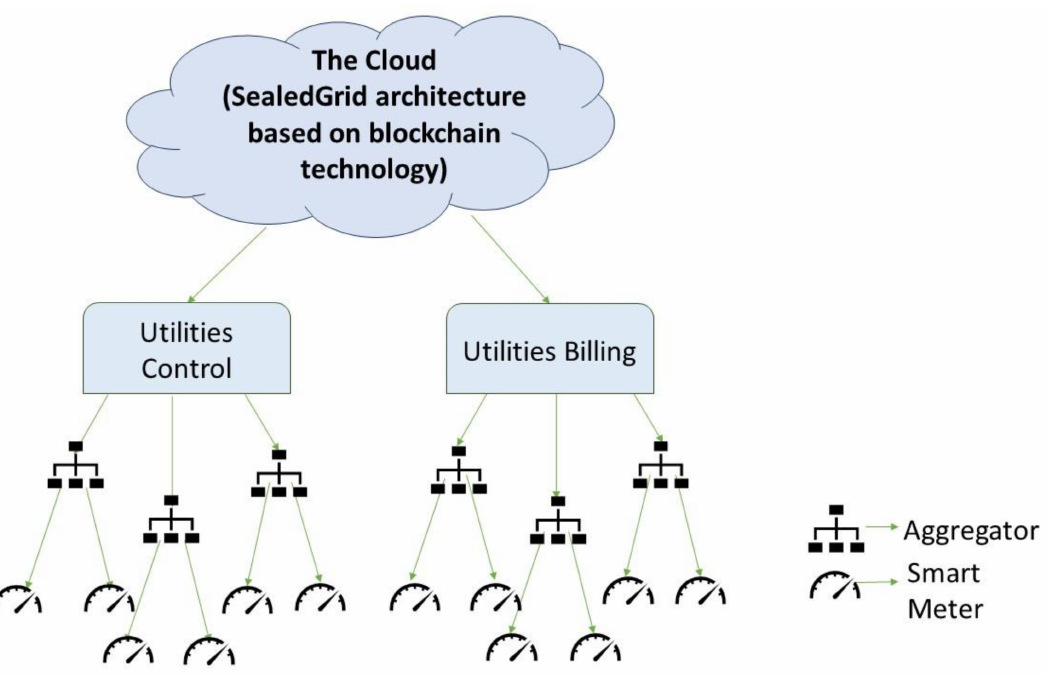
Figure 1. SealedGRID conceptual functional